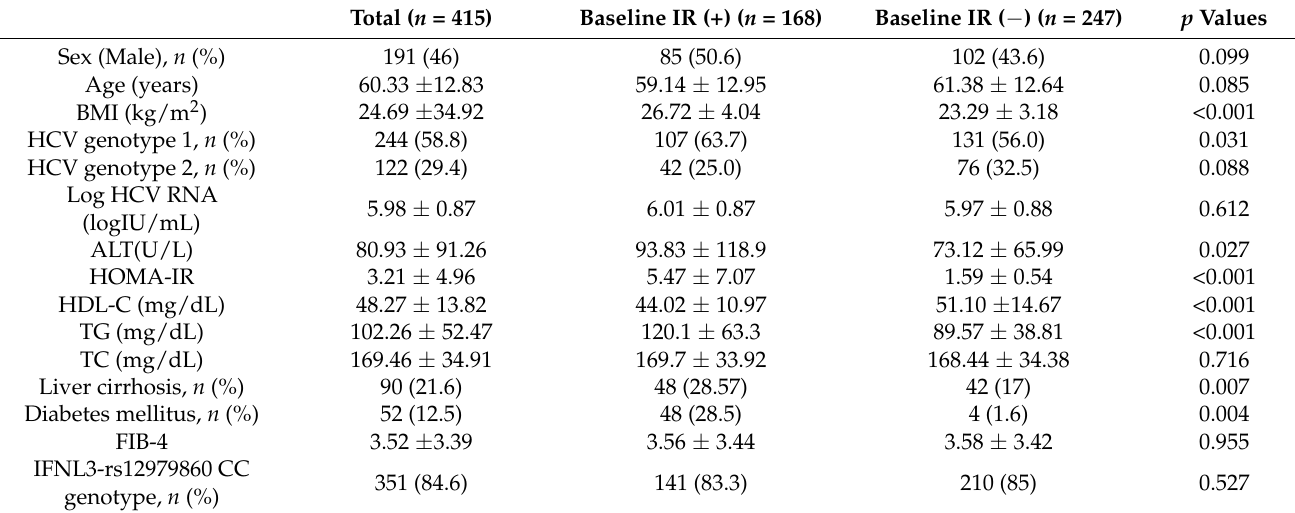
Table 1. Baseline characteristics of the CHC